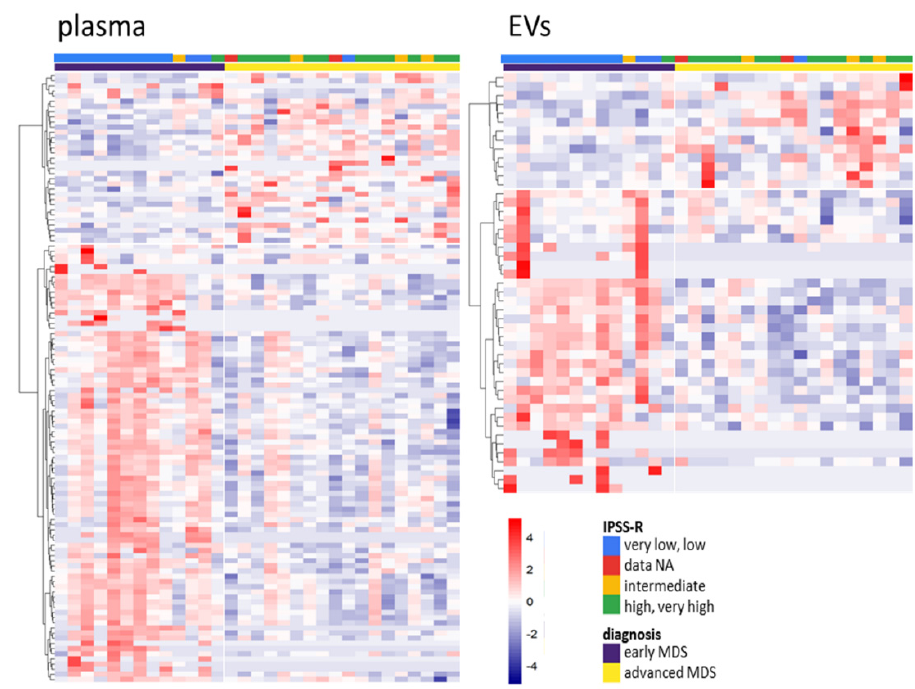
Figure 3. Heatmaps of differentially represented sncRNAs between early and advanced myelodysplastic syndromes (MDS) in total plasma (left) and EVs (right) ( q < 0.05). The color gradient intensity scale shows the row z-score of counts per million (CPM; binary logarithm) of individual RNAs. Red indicates an increased level of an RNA, blue indicates a decreased level of an